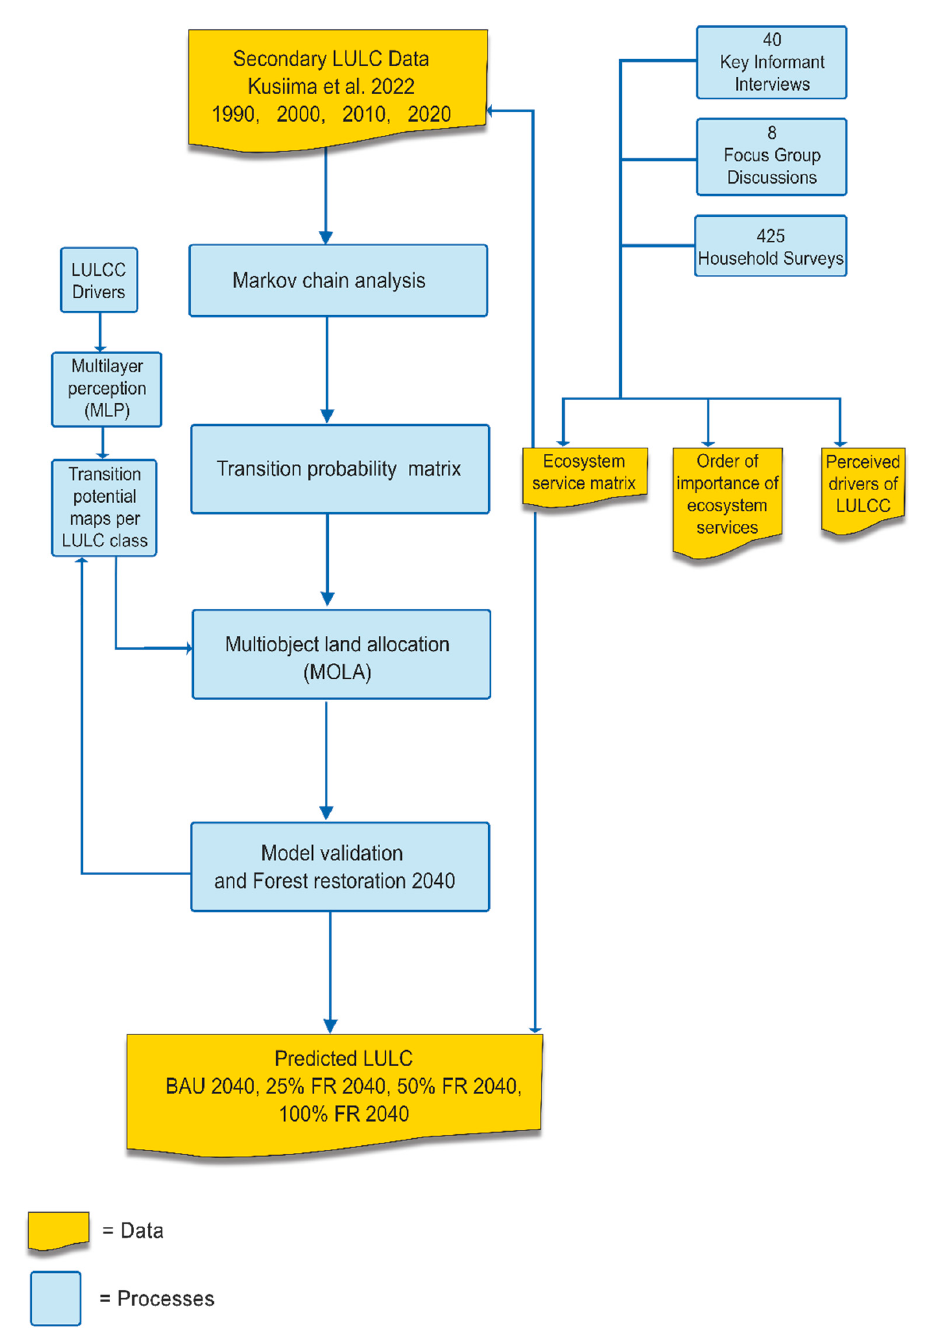
Figure 2. Schematic diagram of the research methods used in the study